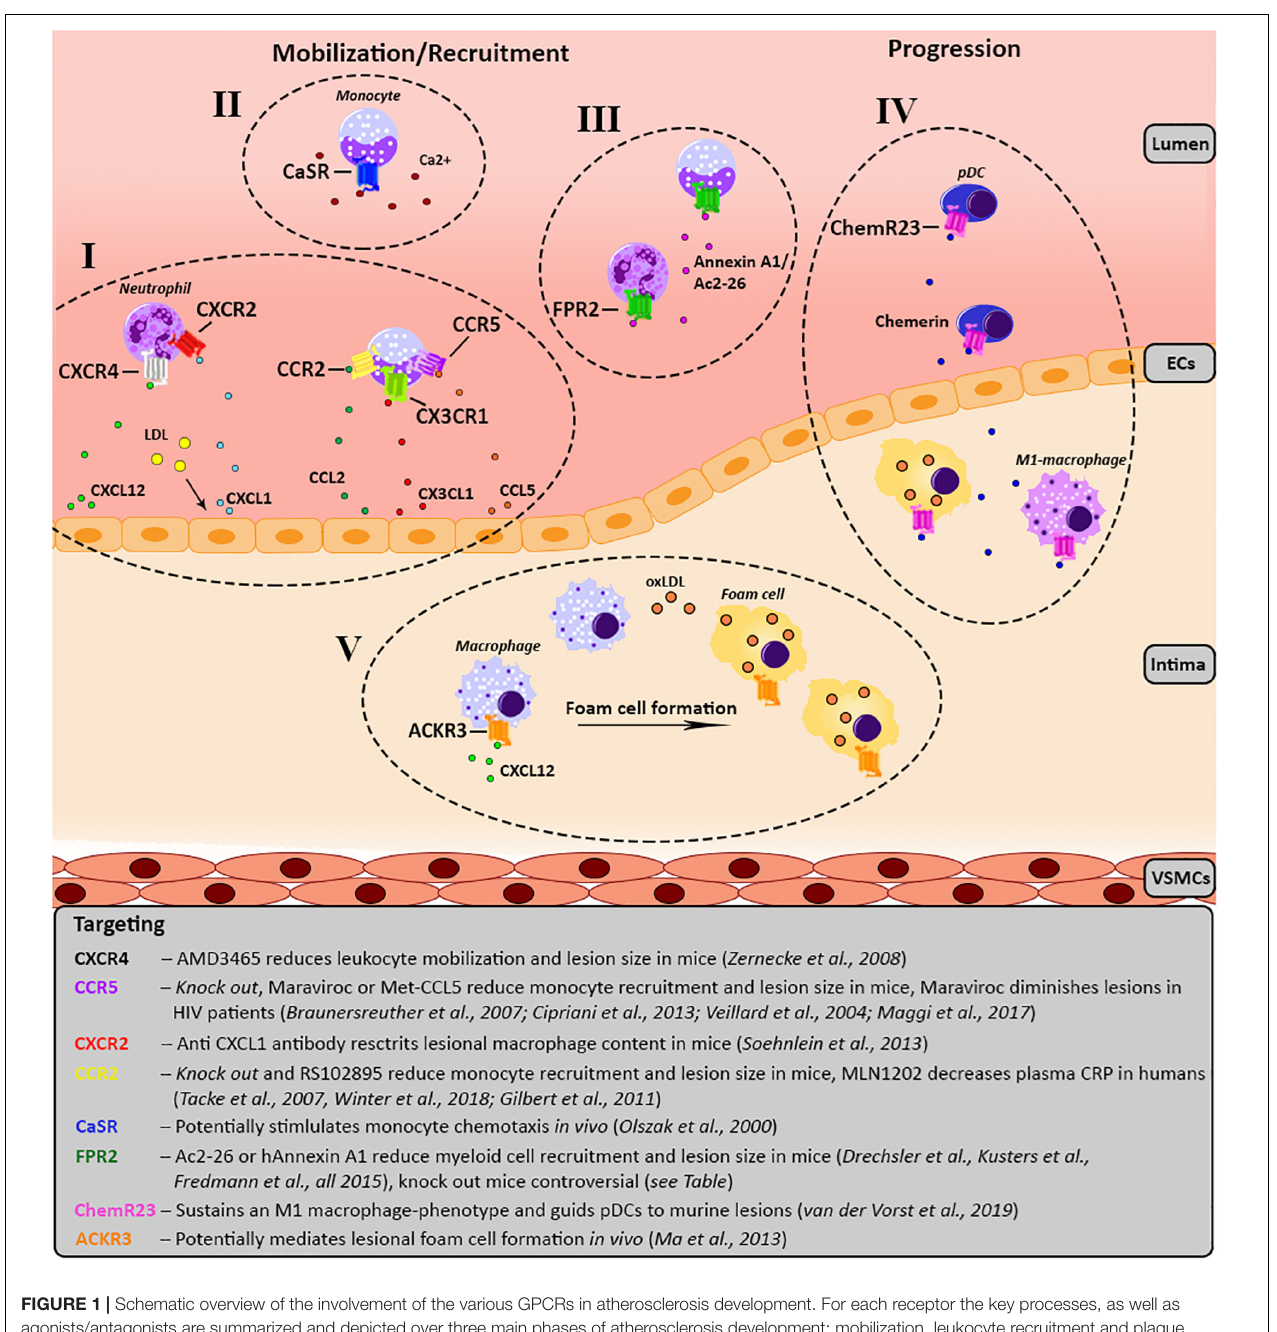
FIGURE 1 | Schematic overview of the involvement of the various GPCRs in atherosclerosis development. For each receptor the key processes, as well as agonists/antagonists are summarized and depicted over three main phases of atherosclerosis development; mobilization, leukocyte recruitment and plaque progression. Receptors of the same GPCR-subfamily are clustered together and categorized from I till V. (I) Chemokine receptor CXCR4 causes migration of leukocytes toward its ligand CXCL12. Additionally, upon LDL stimulation CXCL1 is released by endothelial cells causing myeloid cells, which carry CXCR2 on their surface to migrate toward the endothelium. CCL2 and CX3CL1 mediate the recruitment of monocytes expressing CCR2 and CX3CR1, respectively. In line with this, monocytes expressing CCR5 are recruited to the lesion by CCL5. (II) Monocytes show a CaSR-dependent increase of chemotaxis toward CCL2 upon stimulation with calcium. (III) FPR2 is mostly expressed on myeloid cells and has several contradictory effects, please see Table 1 . FPR2-agonists like Ac2-26, an Annexin A1 peptide, and Annexin A1 reduce monocyte/neutrophil recruitment. (IV) ChemR23 maintains a M1 macrophage phenotype and stimulates pDC migration and infiltration into atherosclerotic plaques. (V) ACKR3 expression is upregulated in lesional macrophages which engulf modified lipids resulting in foam cell formation. ACKR3, atypical chemokine receptor 3; CAD, coronary artery disease; CaSR, calcium-sensing receptor; CCR, C-C chemokine receptor; CCL, C-C chemokine ligand; ChemR23, chemerin receptor 23; CRP, C-reactive protein; CXCR, C-X-C chemokine receptor; CX3CR1, CX3C chemokine receptor 1; CXCL, C-X-C chemokine ligand; CX3CL1, CX3C chemokine ligand 1; FPR2, formyl-peptide receptor 2; HIV, human immunodeficiency virus; LDL, low-density lipoprotein; oxLDL, oxidized LDL; pDC, plasmacytoid dendritic